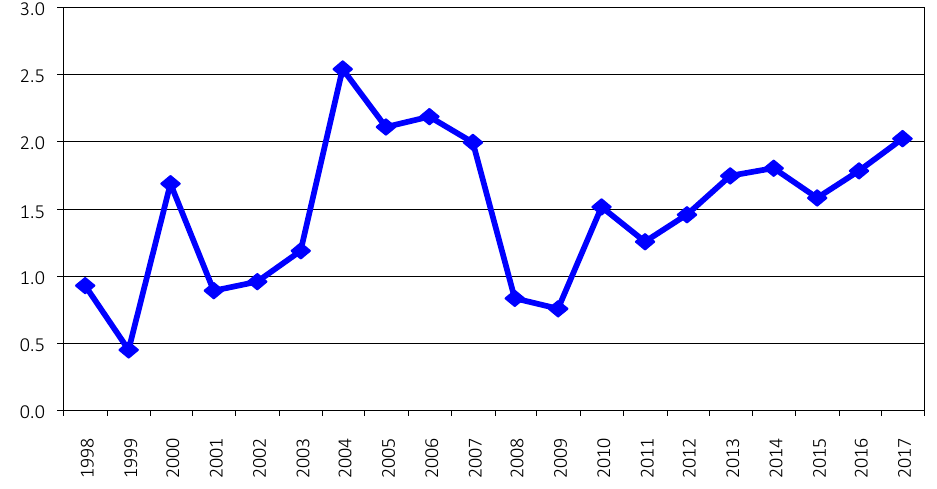
Figure 1. Financial stability index of the global banking system (PR)